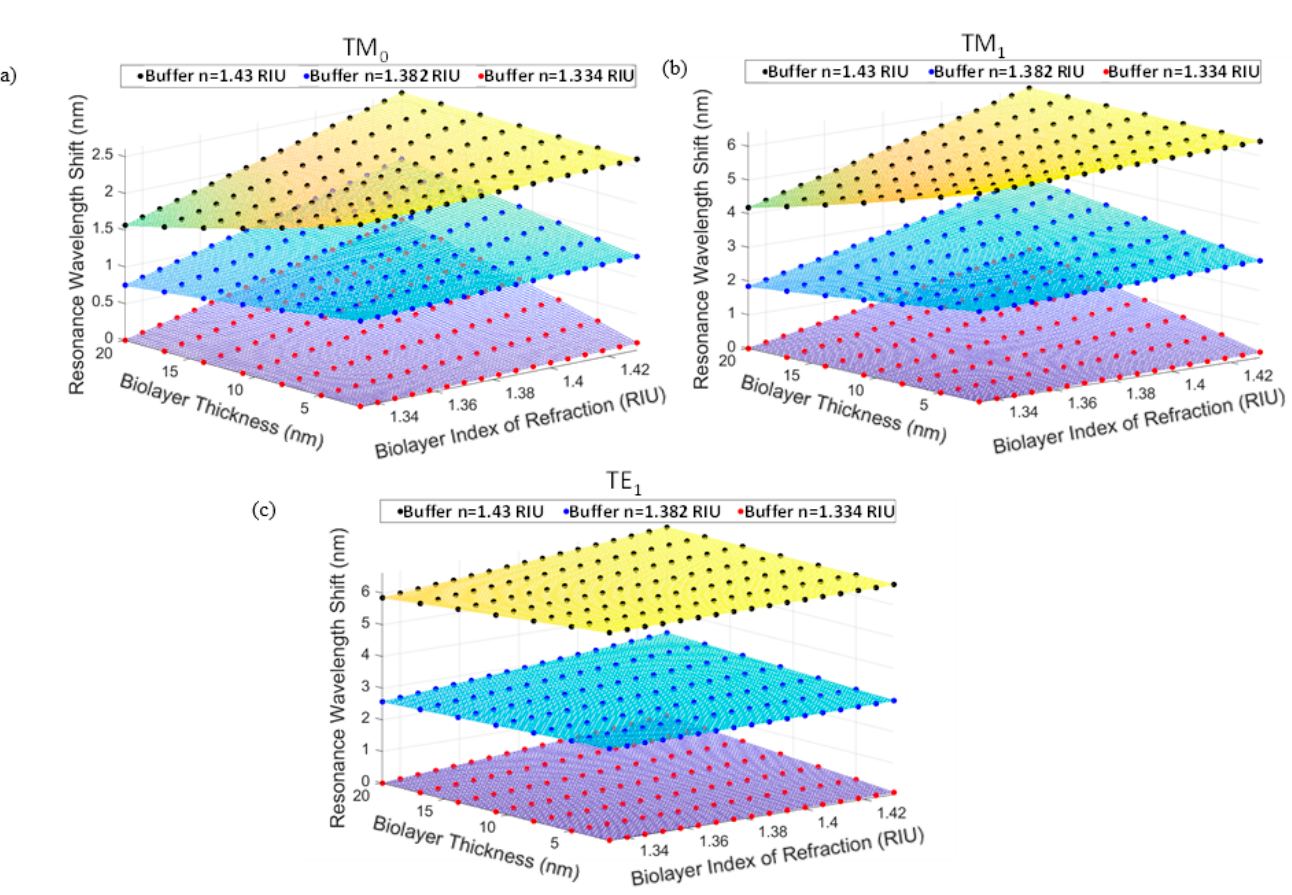
Figure 5. A plot of the simulated ( a ) TM 0 resonance wavelength shifts for a given biolayer index of refraction and biolayer thickness for the biosensor shown in Figure 1a; each sheet of simulation data represents a different value of bulk index of refraction (buffer) as indicated in the legend. This plot is also produced for the ( b ) TM 1 and ( c ) TE 1 modes of light.